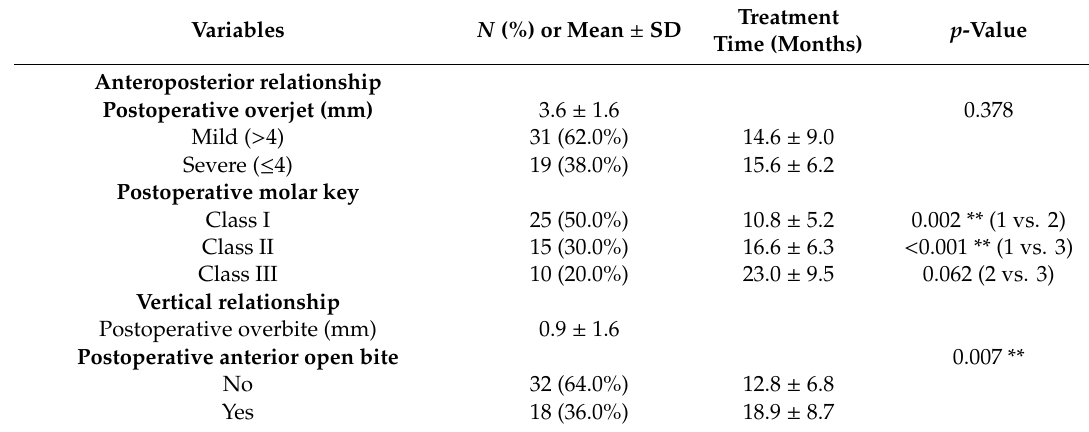
Table 2. Impact analysis on treatment time according to the surgical occlusion